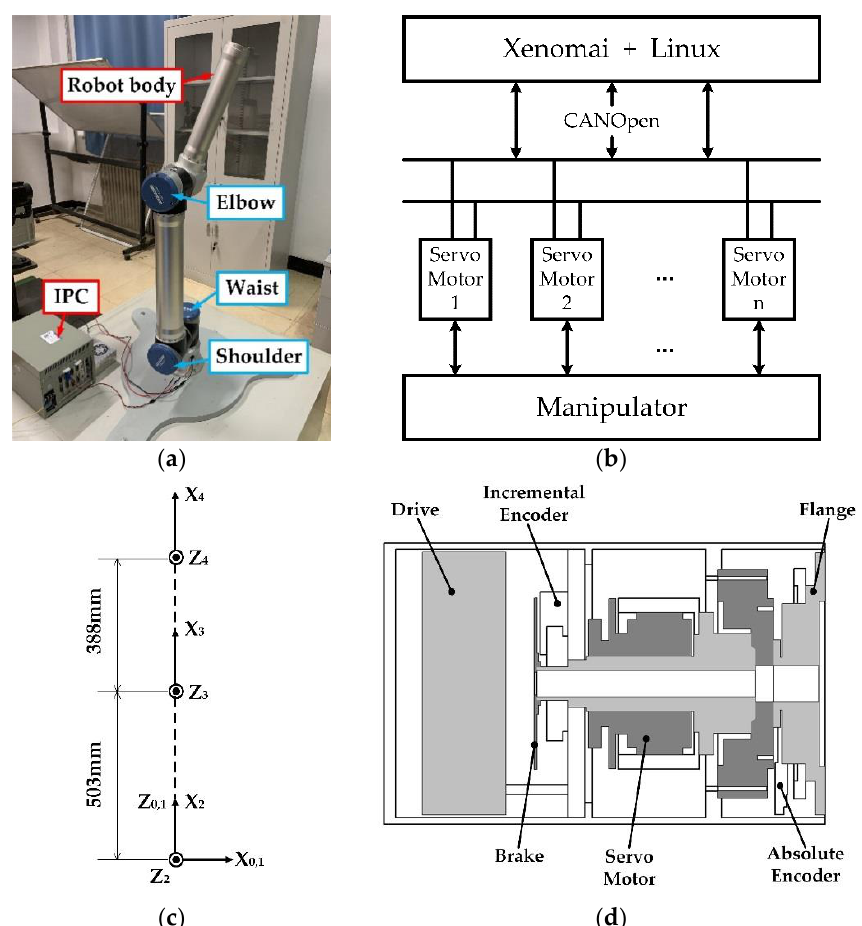
Figure 3. The structure of the test platform and control system: ( a ) Prototype of the manipulator; ( b ) Scheme of control communication; ( c ) Parameters of links; ( d ) Diagram of encoder position.